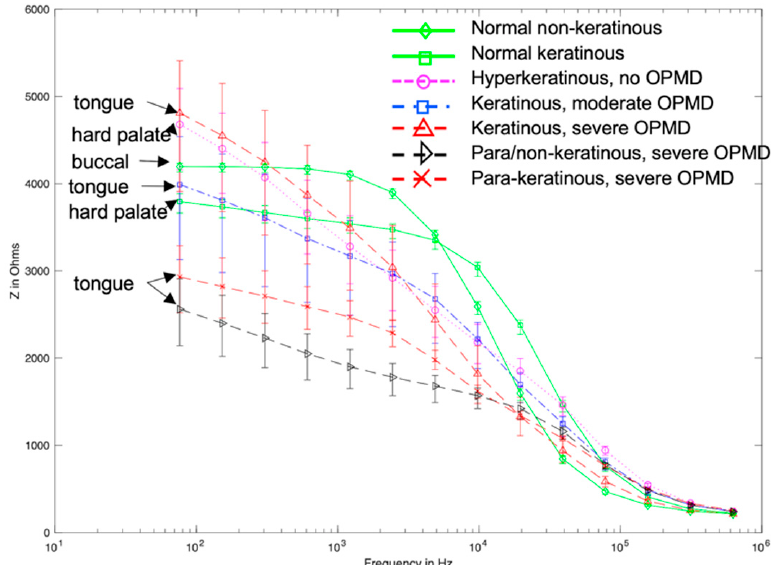
Figure 9. Modelled spectra templates for oral sites of varying keratinisation and pathology. Error bars represent the range of spectra obtained when simulating maximum and minimum measured cellular compartment thickness for each tissue type.